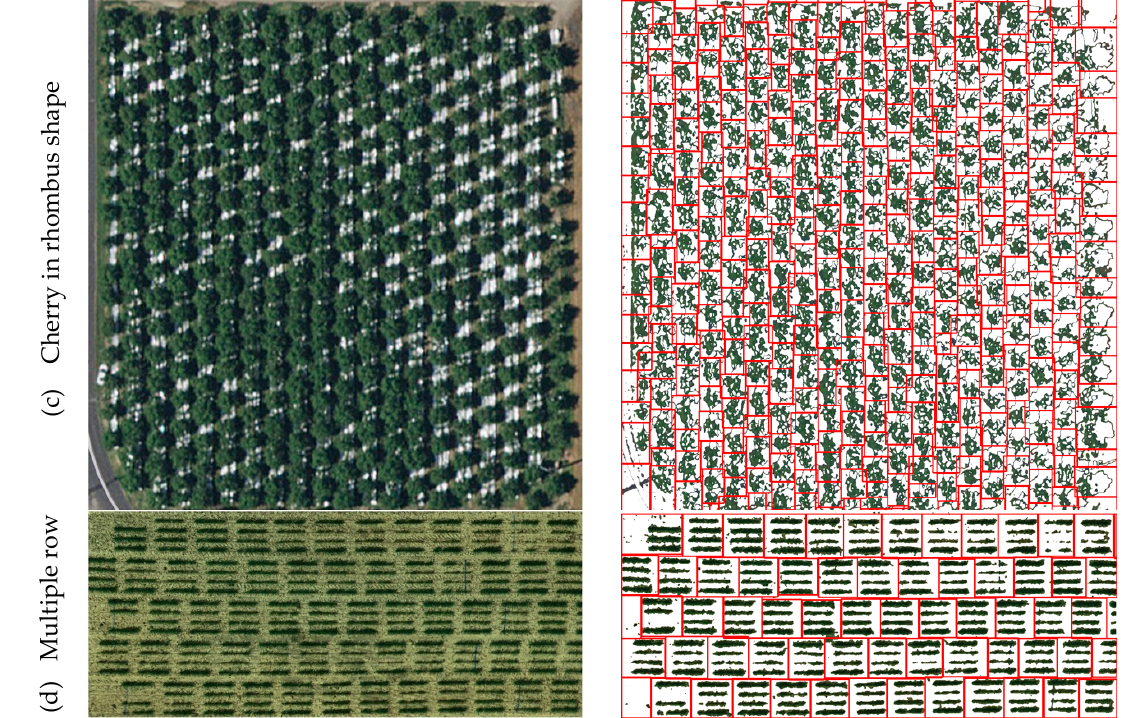
Figure 5. Segmentation of images with different plot layout patterns and resolutions. The patterns include perpendicular layout of alfalfa ( a ), zigzag-like layout of wheat ( b ), rhombus shape of cherry tree orchard ( c ), and multiple rows within plots of pea field ( d ). The alfalfa and pea field drone images were provided by Zhou Tang and Samuel Revolinski. The other two are Google satellites images for wheat on Spillman Agronomy Farm at Washington State University (46°41’50.8”N 117°07’29.1”W) and for cherry trees in Grandview, Washington (46.230664, 119.904291). The left panel displays the raw images and the right panel demonstrates the extracted pixels of interest with plots defined by the red boxes.